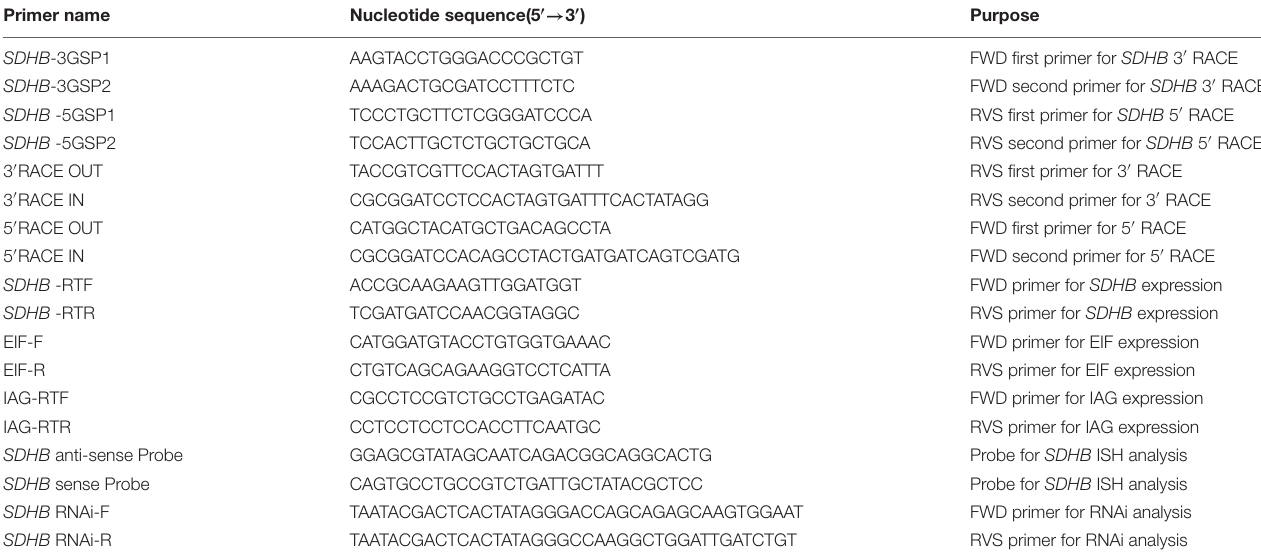
TABLE 1 | Universal and specific primers used in this study.